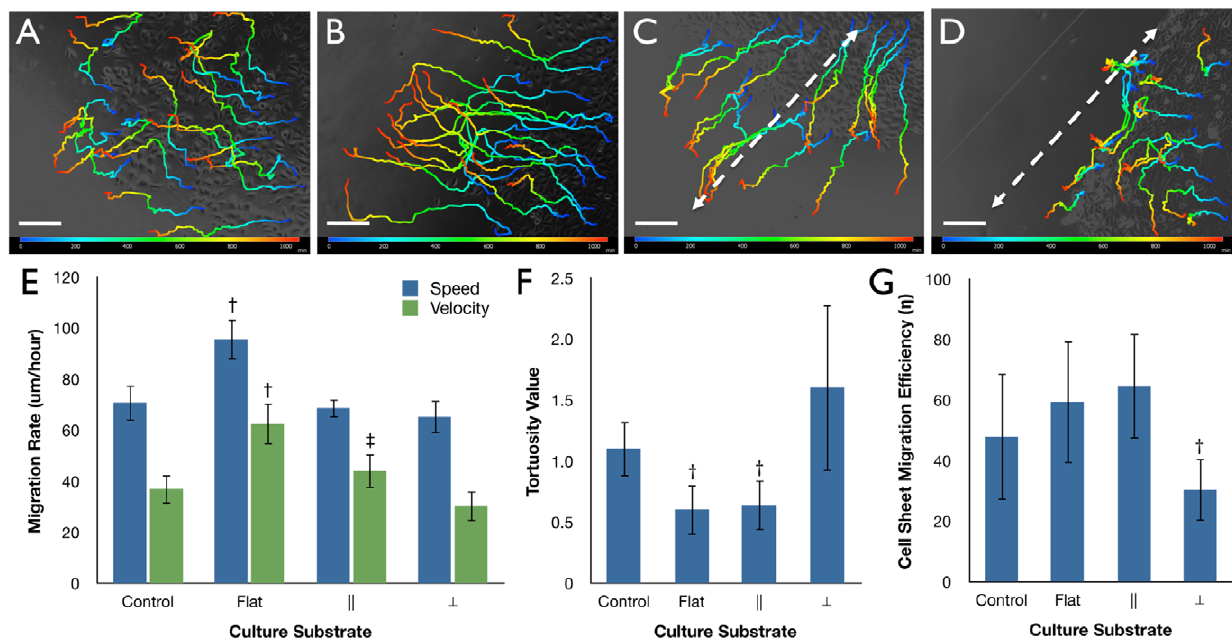
Figure 5. Individual cell migration path on silk substrates. Migratory paths of individual HCLE cells on (A) glass control, (B) flat silk, (C) parallel (||) and (D) perpendicular ( H ) movement to the patterned silk topography over a 10-hour culture period (N=4, n=20). Color indicates time 0 (blue) to 10-hour (red) time points, and white dashed arrows indicate direction of the silk topography (scale bars=200- m m). Singular cell migratory measurements for (E) total distance and straight distance measurements ( { indicates p , 0.05 when compared to culture substrates in similar groups, { indicates p , 0.05 when compared to H ), (F) tortuosity values ( { indicates p , 0.05 when compared to control and H substrates), and (G) migration rate for singular cellular movement upon various substrates ( { indicates p , 0.05 when compared to all other substrates). (H) Cell sheet migration efficiency ( g ) for cultures migrating on the various substrates conditions ( { indicates p , 0.05 when compared to all other substrates). Error bars=SD for all graphs.